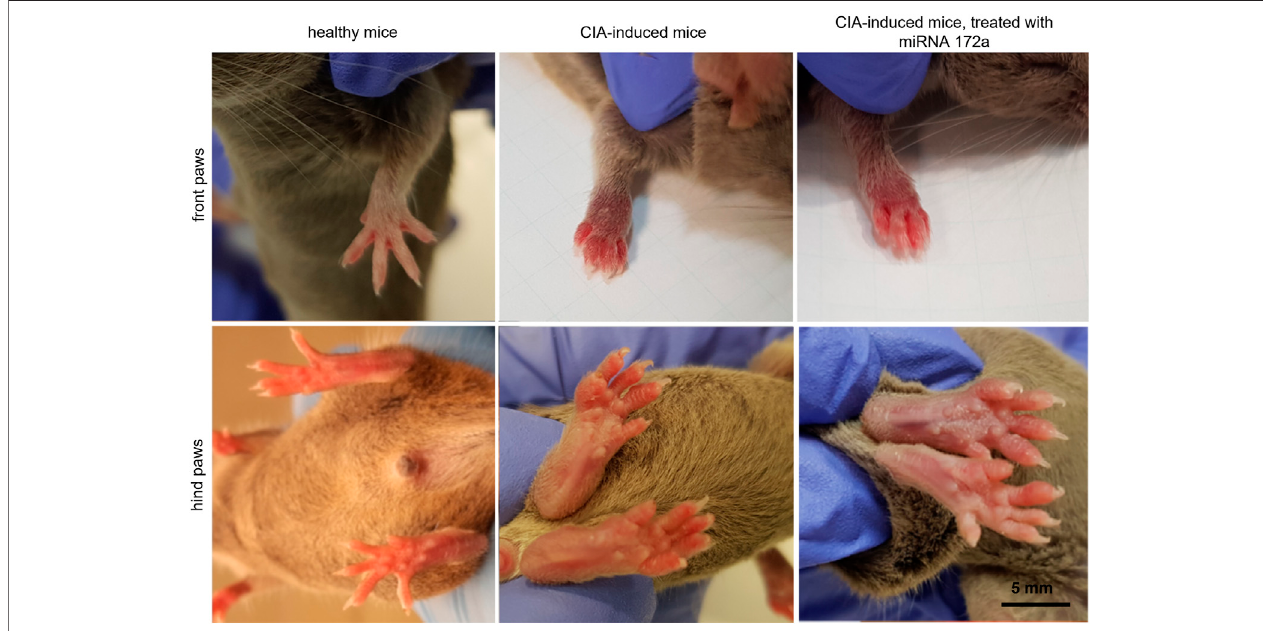
FIGURE 3 | Paw oedema at the 4th week after immunization.